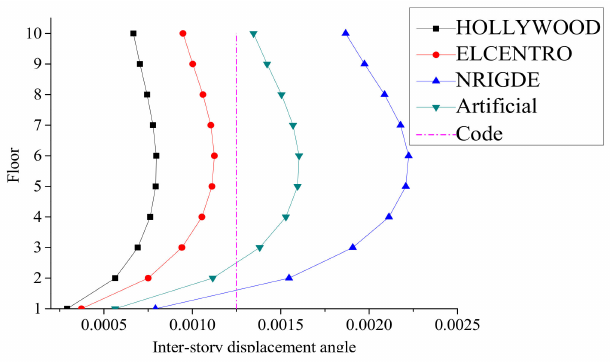
Figure 18. Inter-story displacement angle in case